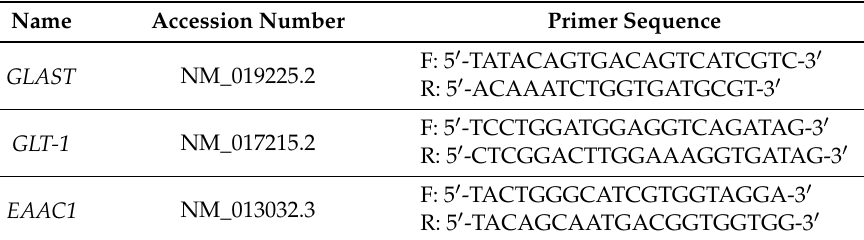
Table 1. Primer sequences of glutamate